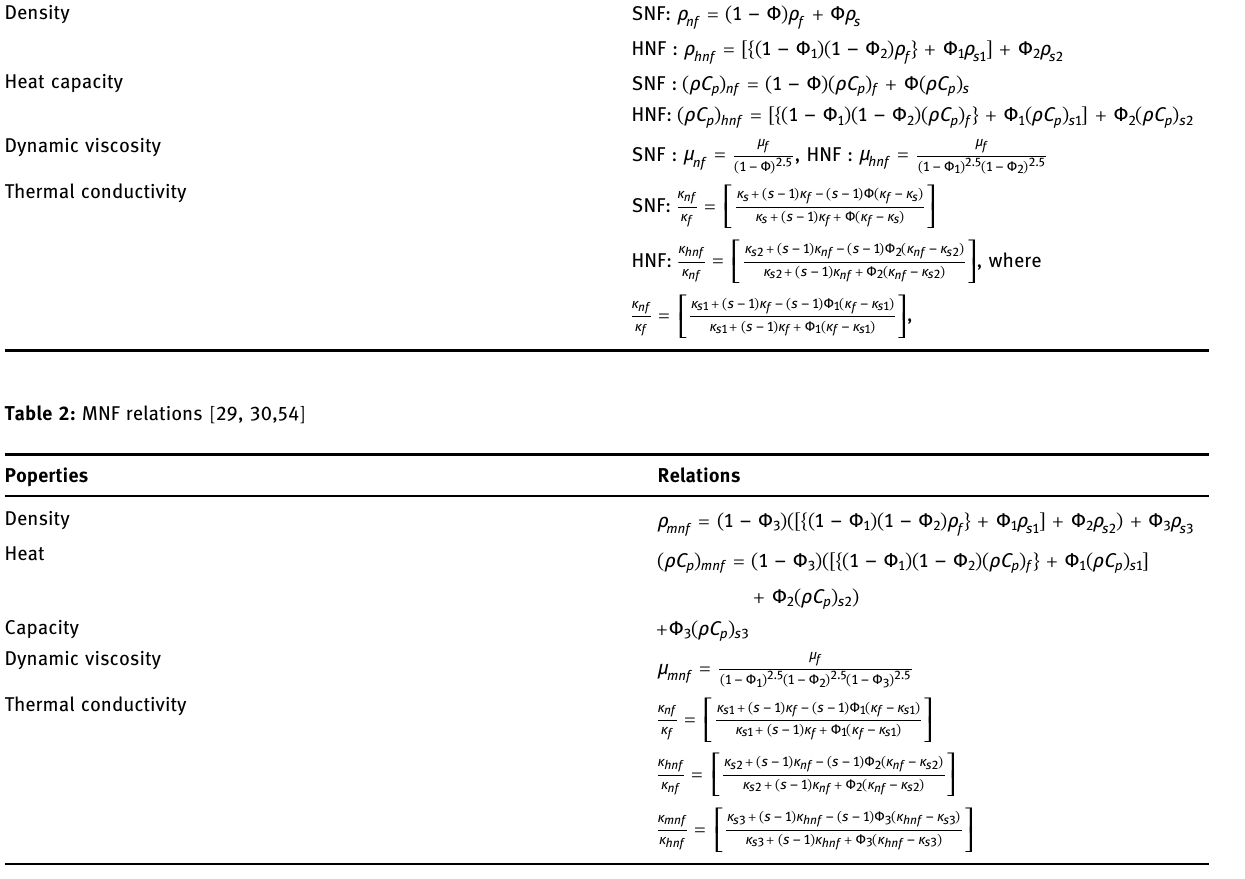
Properties SNF/HNF Density